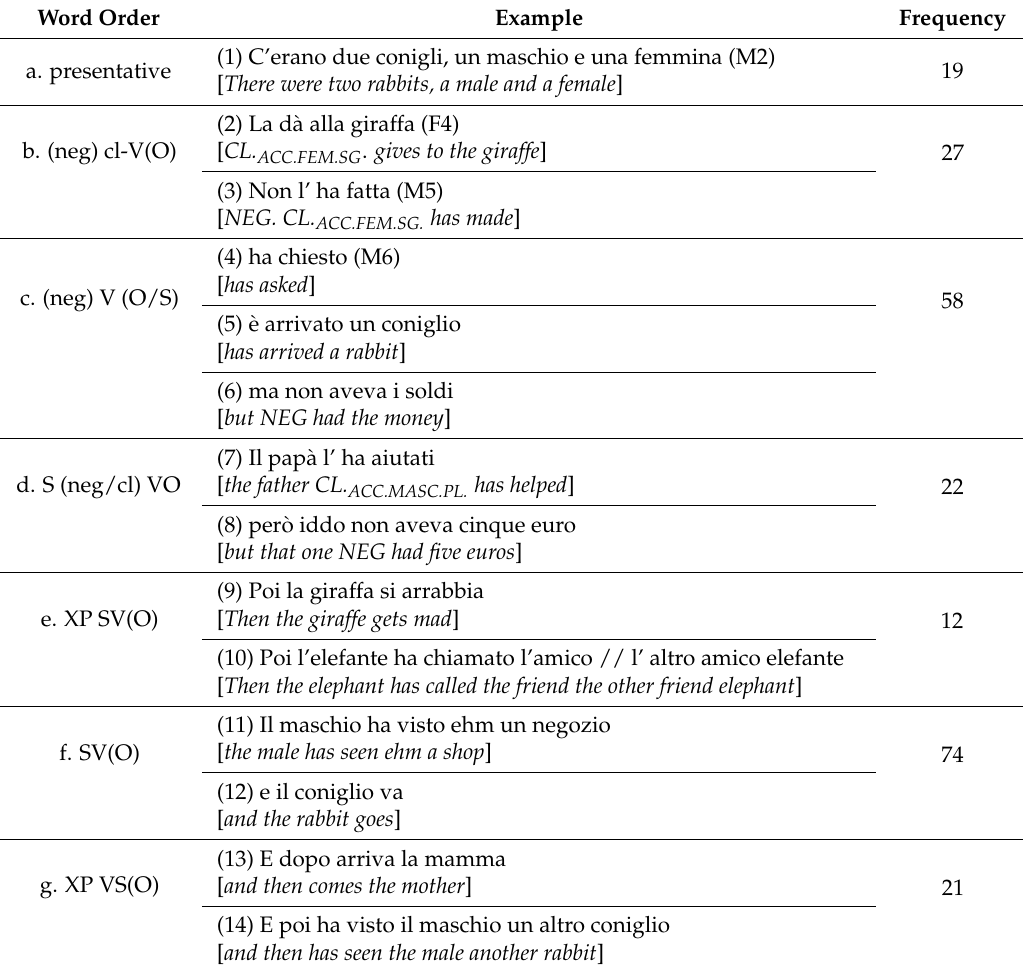
Table 9. Word orders occurring in root contexts in the narratives. While the orders (a.)–(e.) are incompatible with a verb-second (V2) grammar, the orders (f.) and (g.) are consistent with V2. In the description of the different structures (first column), the constituents in parentheses may occur or not. When a slash separates the two constituent types, either one can appear (abbreviations used in the Table: neg : negation; cl :